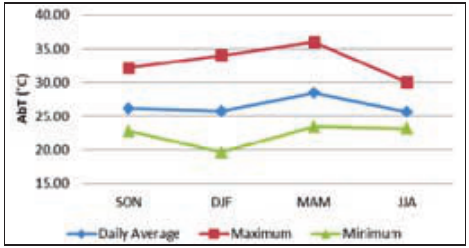
Fig. 2. Quarterly means of ambient temperature